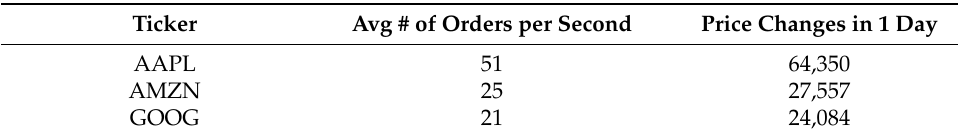
Table 1. Stock liquidity of AAPL (Apple), AMZN (Amazon), and GOOG (Google) for 21 June 2012 (Swishchuk and Huffman 2020).